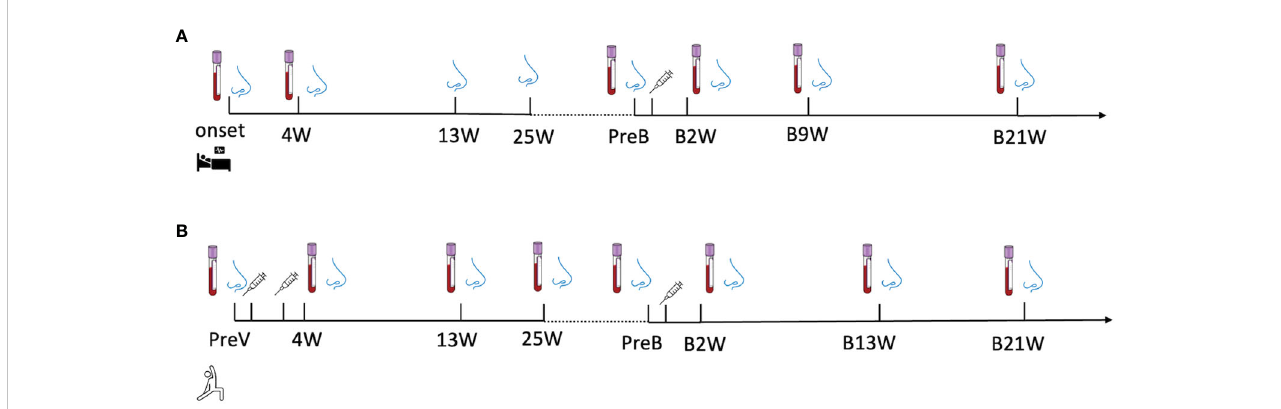
FIGURE 1 A longitudinal sample collection in (A) recovered subjects from the day of diagnosis (disease onset) to twenty-one-week post-vaccination and in (B) vaccine-only subjects from 0-to-2 days before the fi rst dose of vaccine to thirteen weeks post-third dose of vaccine. The nose and blood cartoons indicate the time points when NELF and plasma were collected. The syringe cartoon indicates the time points when subjects received